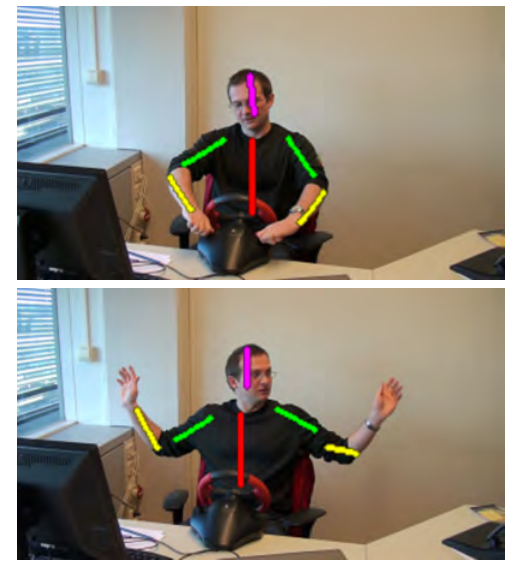
Figure 9. Hierarchy of driver activity.